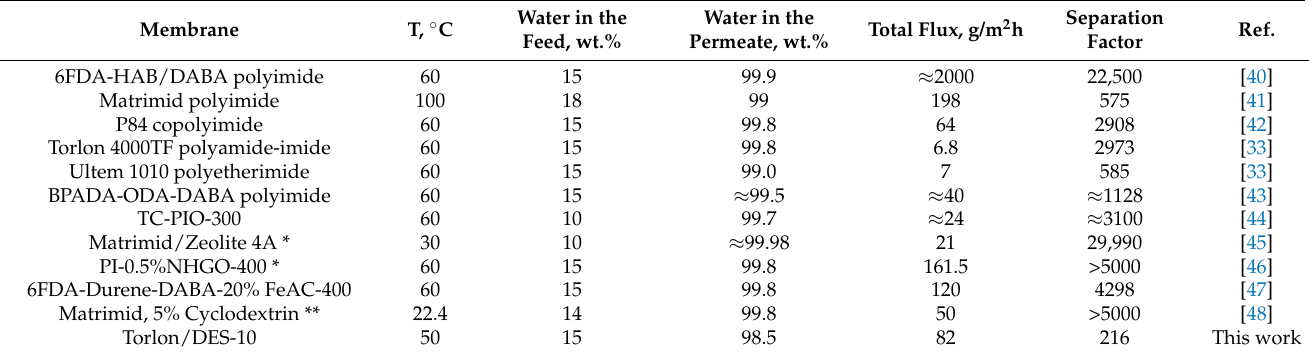
Water in the Water in the Separation Ref. Total Flux, g/m 2 h Feed, wt.% Permeate, wt.% Factor